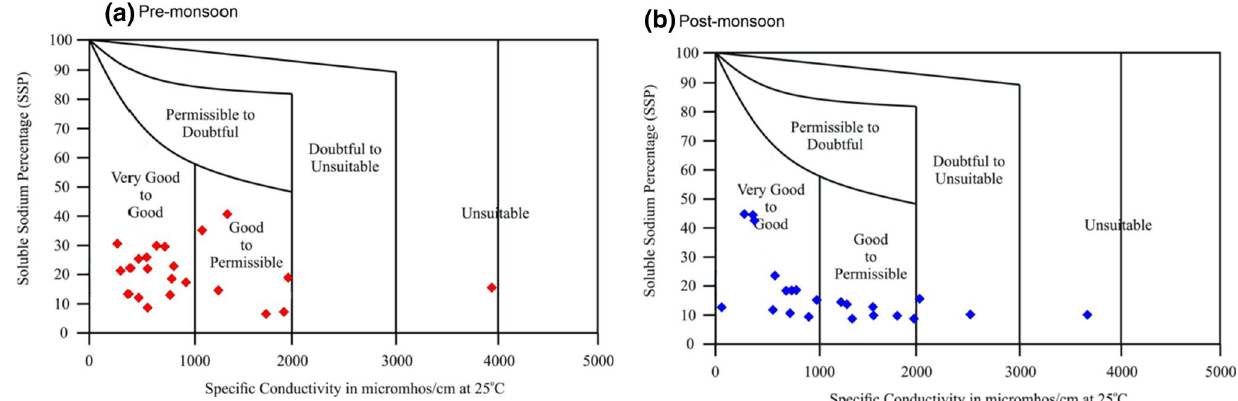
Fig. 10 Wilcox diagram a PrM; b